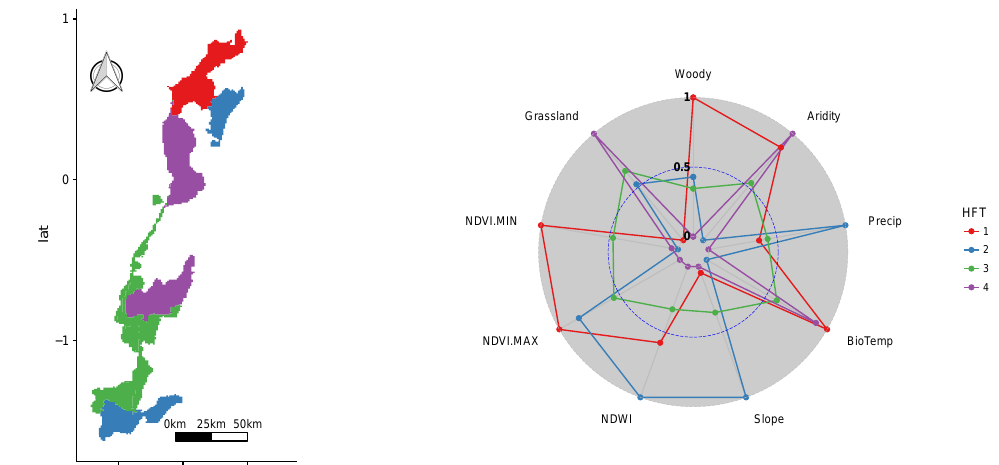
Figure 5. Map of HFTs identified in the Virunga National Park and normalized mean values of the biophysical variables used (European Petroleum Survey Group—EPSG:4326). The description of the study variables can be found in Section 2.2.